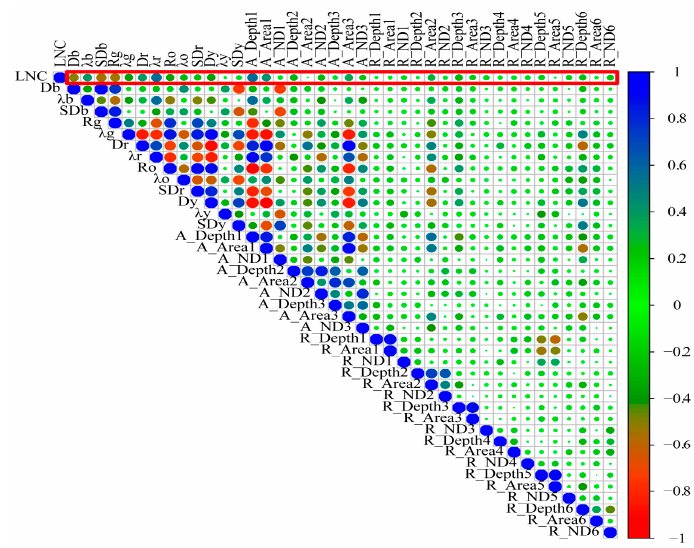
Figure 5. Correlations between LNC and special positions (in red boxes, n = 48). Table 5. Modeling results between position features and LNC.